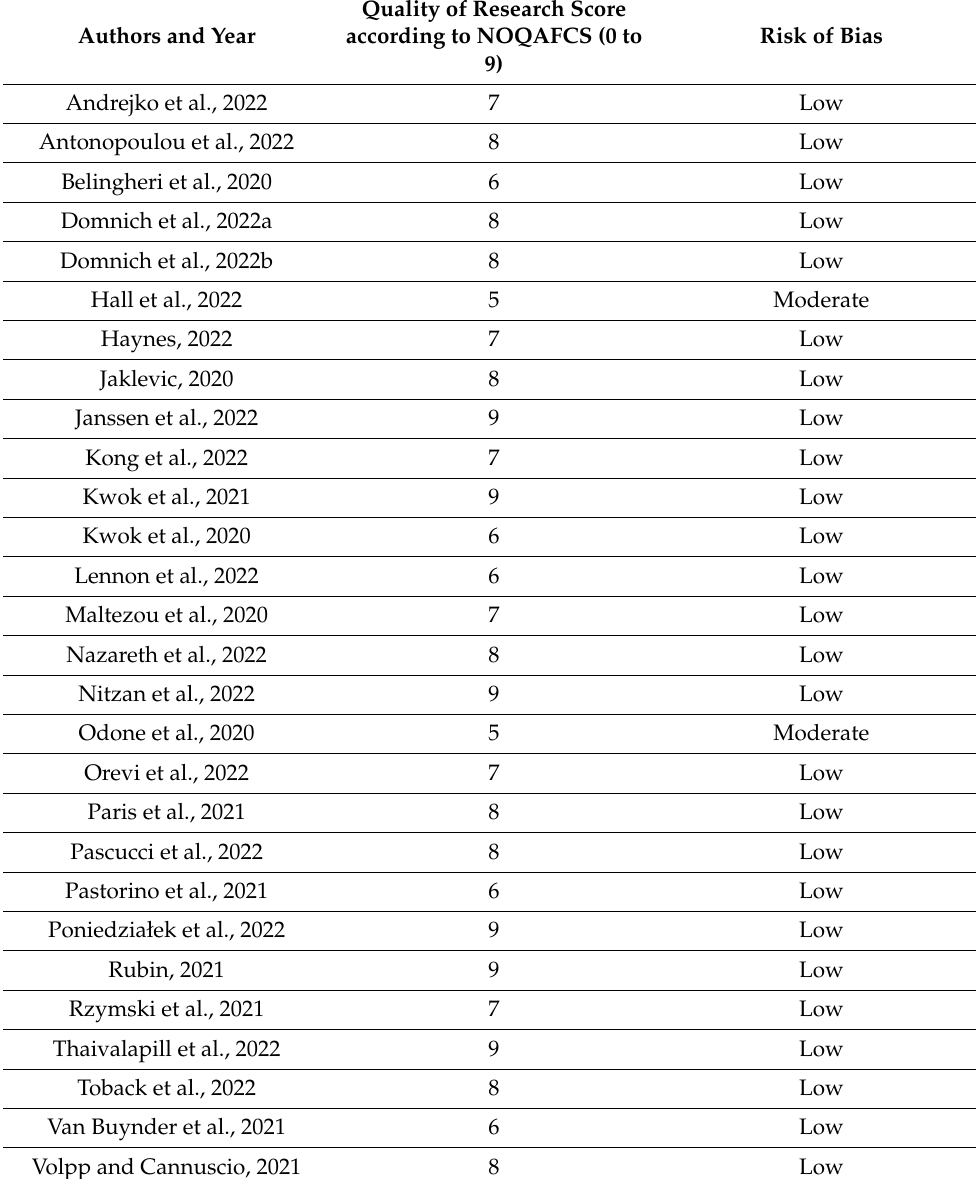
Table 2. Risk of bias assessment